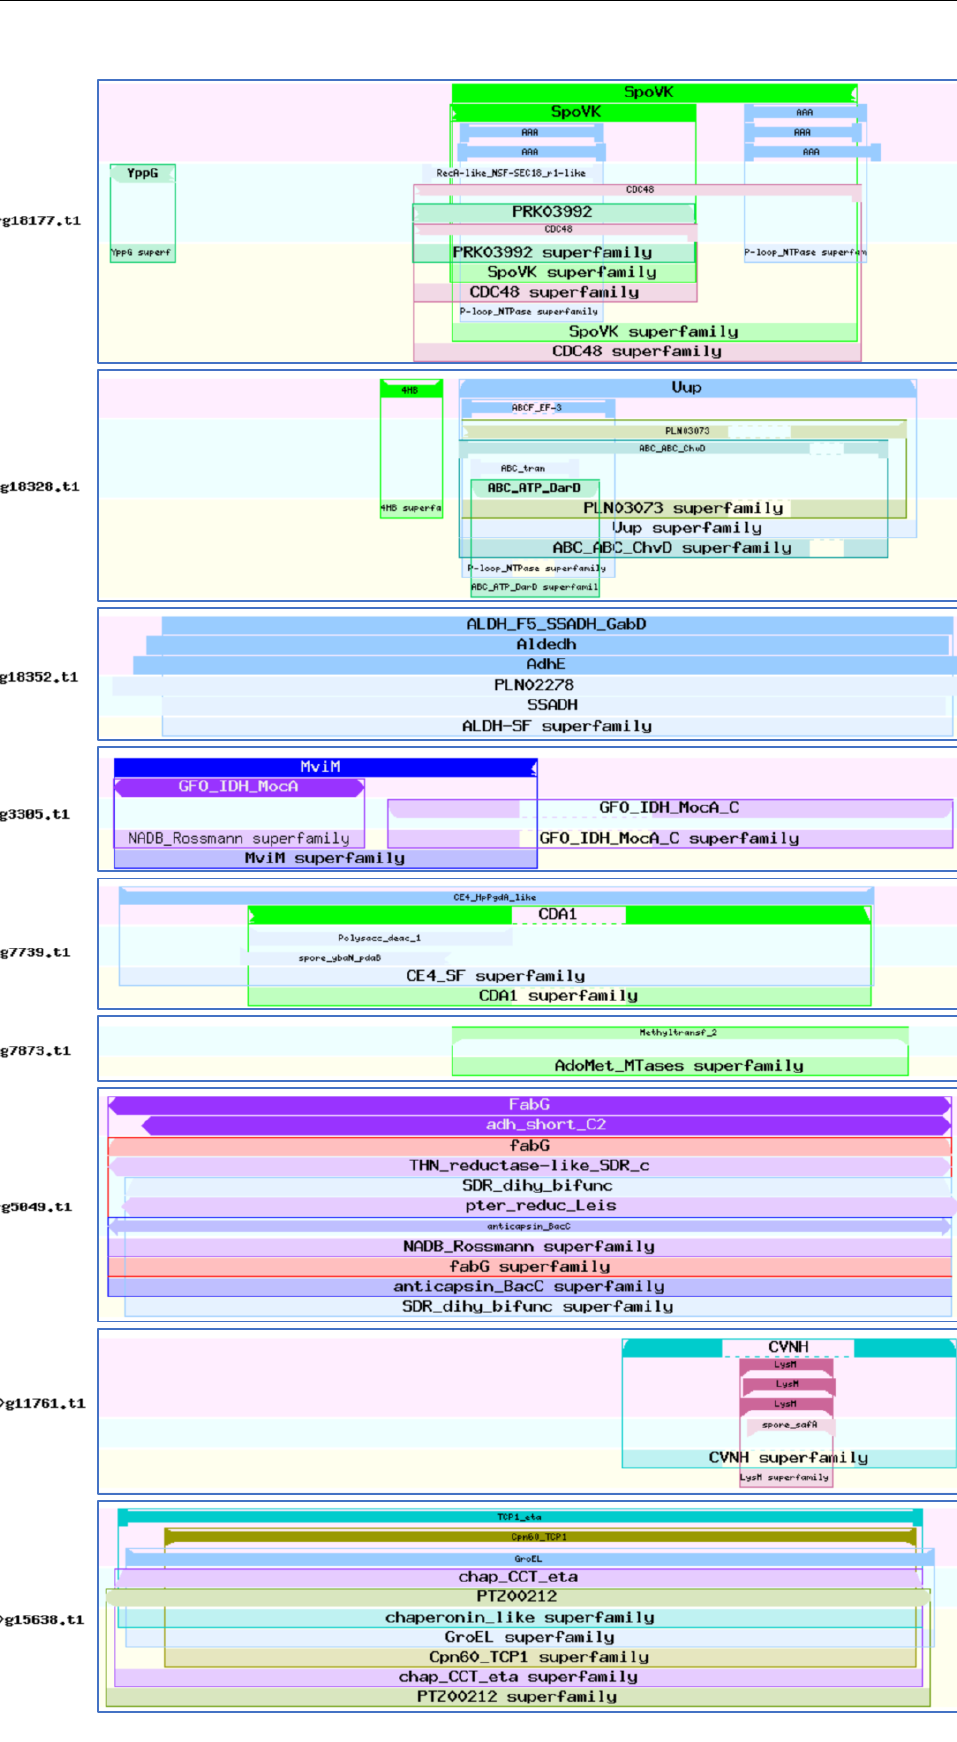
Figure 7. Abundant conserved protein domain. Analysis of 46 virulence-associated genes domains. (https://www.ncbi.nlm.nih.gov/Structure/bwrpsb/bwrpsb.cgi?), accessed on 6 May